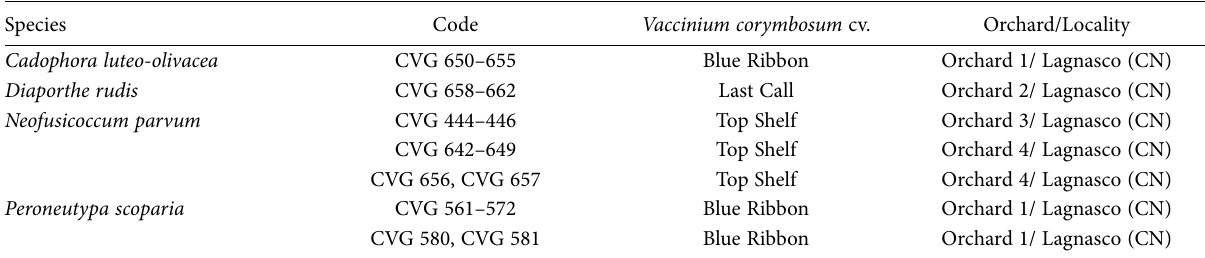
Table 2. Origin of fungal isolates obtained from Vaccinium corymbosum